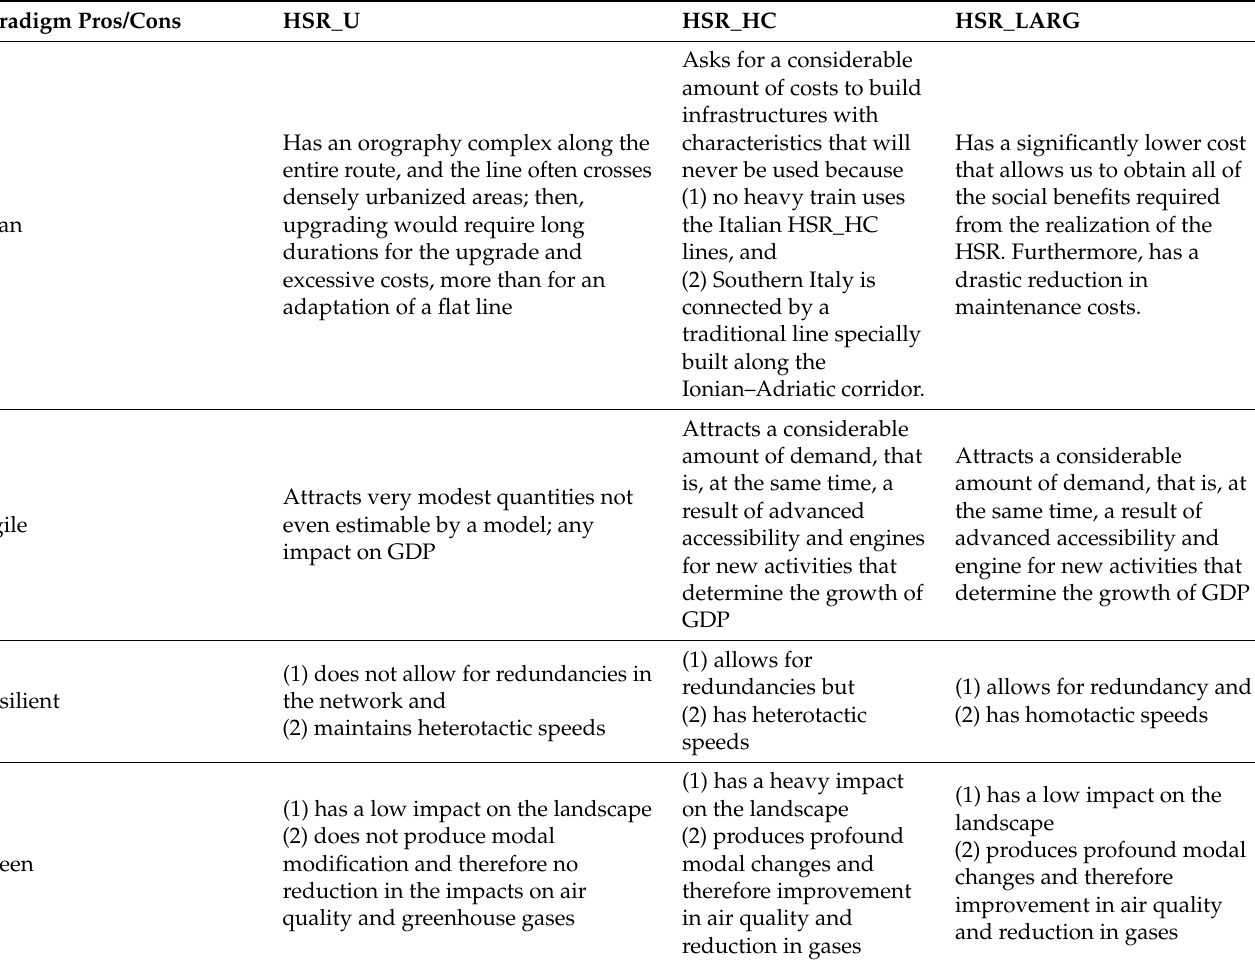
Table 5. Main pros and cons for each paradigm and each